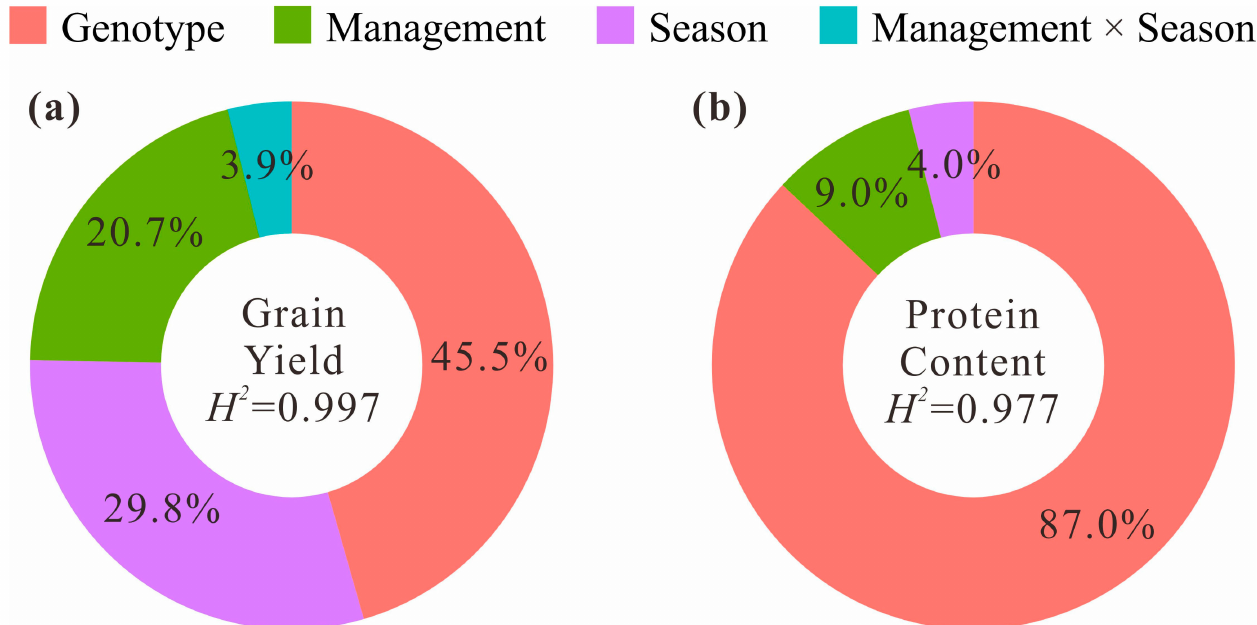
Figure 2. Proportion of variance components affecting the grain yield (GY) ( a ) and protein content (PC) ( b ) in wheat by genotype, management condition, growing season, and heritability ( H 2 , generalized) in 69 allelic